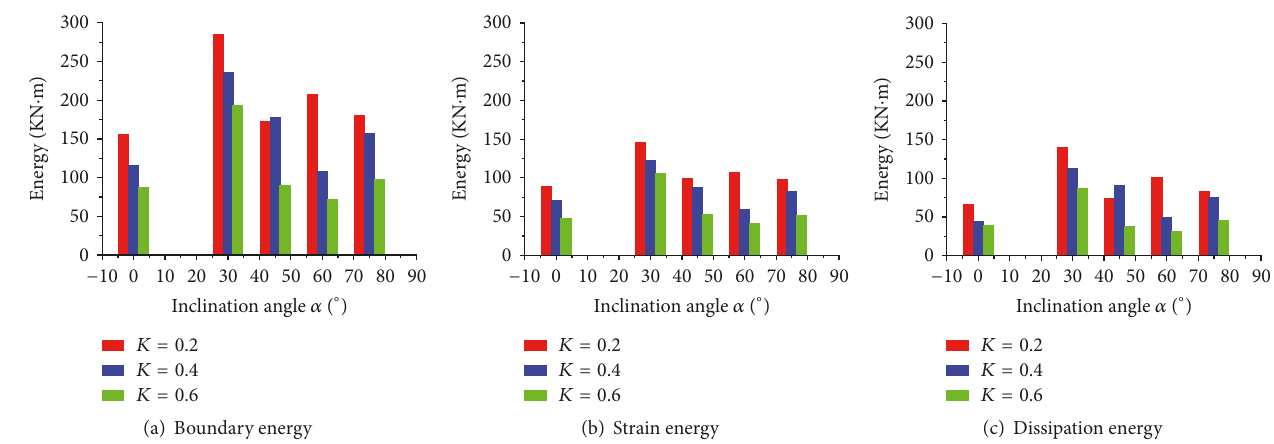
Figure 17: Energy of jointed specimens with different 𝑘 in PFC